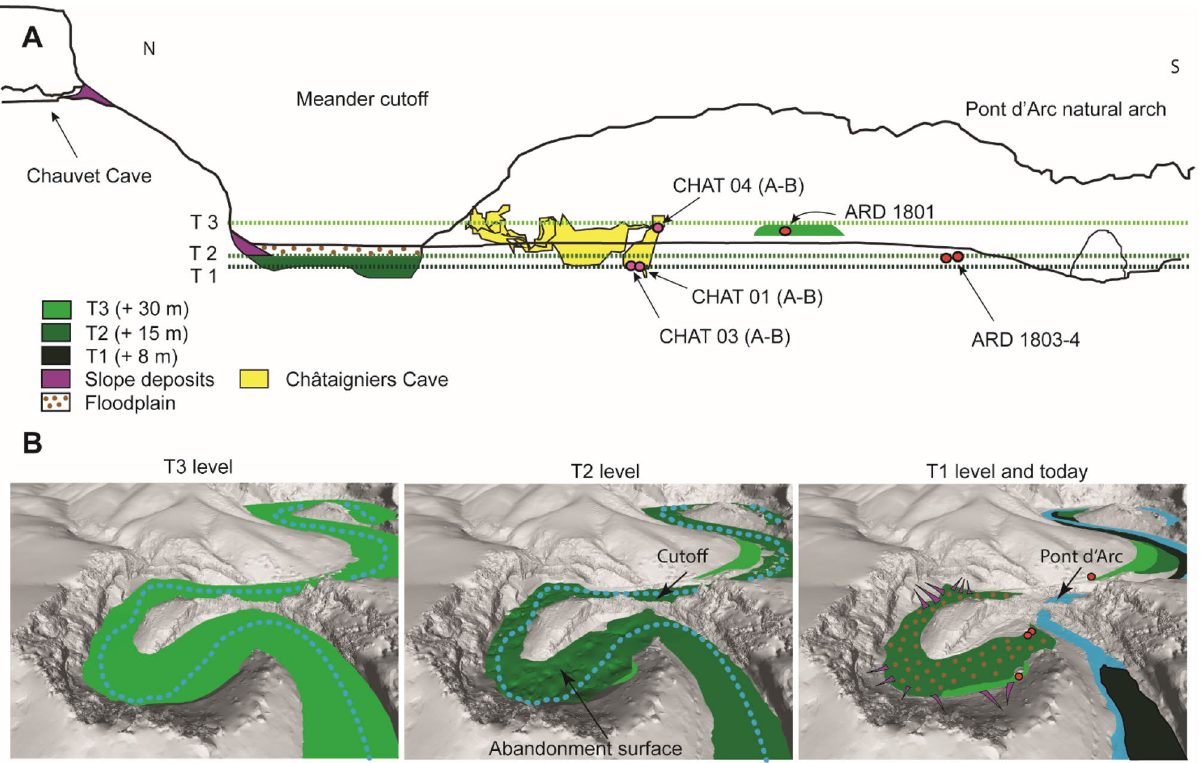
Figure 4. Landscape evolution of the Combe d’Arc meander. ( A ) Cross-section through the Combe d’Arc meander cutoff showing sampling points for the alluvial deposits and speleothems. T1, T2, and T3 correspond to the alluvial deposits at + 8 m, + 15 m, and + 30 m respectively. The diagram shows the altitude of the T1 level in the Combe d’Arc meander cutoff, but this level is not present in this area. 3D reconstruction of the three phases in the meander cutoff process showing theoretical extents of alluvial deposits (green